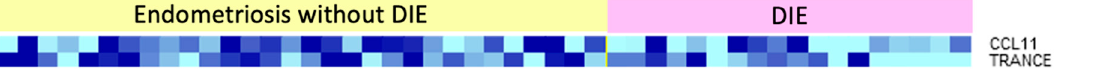
Figure 3. Heat map representing the target proteins that showed a significantly different concentration in plasma of patients with deep-infiltrating endometriosis (DIE) and endometriosis patients without DIE. The color intensity correlates with the expression level of the protein.